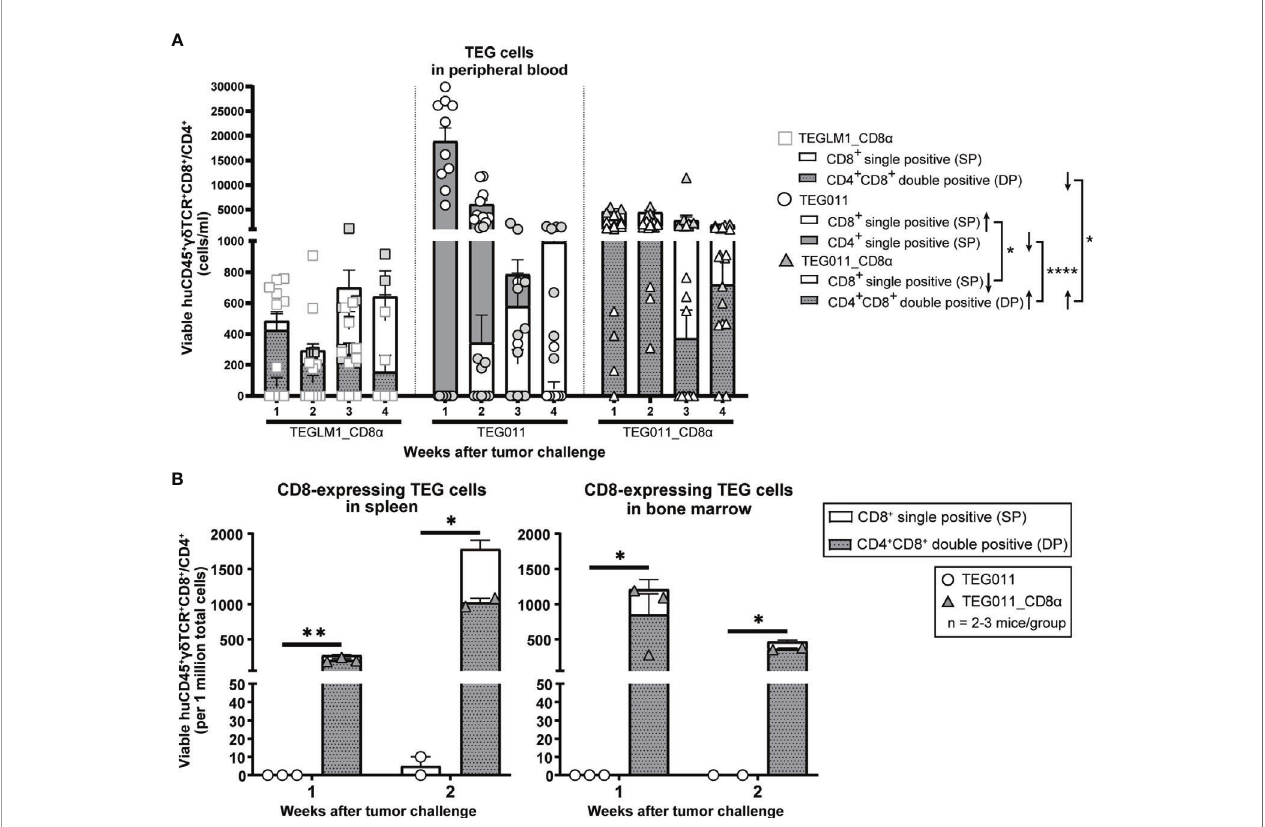
FIGURE 3 | TEG011_CD8 a enhances TEG persistence and in fi ltration. (A) TEG cells were measured in peripheral blood using fl ow cytometry by quantifying the absolute cell numbers of TEGLM1_CD8 a mock (open light gray rectangle), TEG011 (open black circle), and TEG011_CD8 a (open black triangle) in tumor-bearing mice. TEG cells are distinguished into different cellular compartments: CD8 + single-positive (SP; white stacked bar), CD4 + single-positive (SP; gray stacked bar), and CD4 + CD8 + double-positive (DP; gray dotted stacked bar) cells. Black arrows indicate higher or lower T cell counts observed. Data are shown as mean ± SEM of all mice per group (n = 10 mice). Statistical signi fi cances were calculated by a mixed-effects model with repeated measures (*P < 0.05; ****P < 0.0001). (B) CD8- expressing TEG cells was assessed in spleen and bone marrow by quantifying the total viable cells of huCD45 + gd TCR + CD8 + and huCD45 + gd TCR + CD4 + CD8 + per one million single-cell suspension by fl ow cytometry. Cell counts of individual mouse per treatment group are represented by each symbol. Functional TEG011 cells consist of two different cellular compartments: CD8 + single-positive (SP; white stacked bar) and CD4 + CD8 + double-positive (DP; gray dotted stacked bar). Data are shown as mean ± SEM (*P < 0.05; **P < 0.01) calculated by a mixed-effects model with repeated